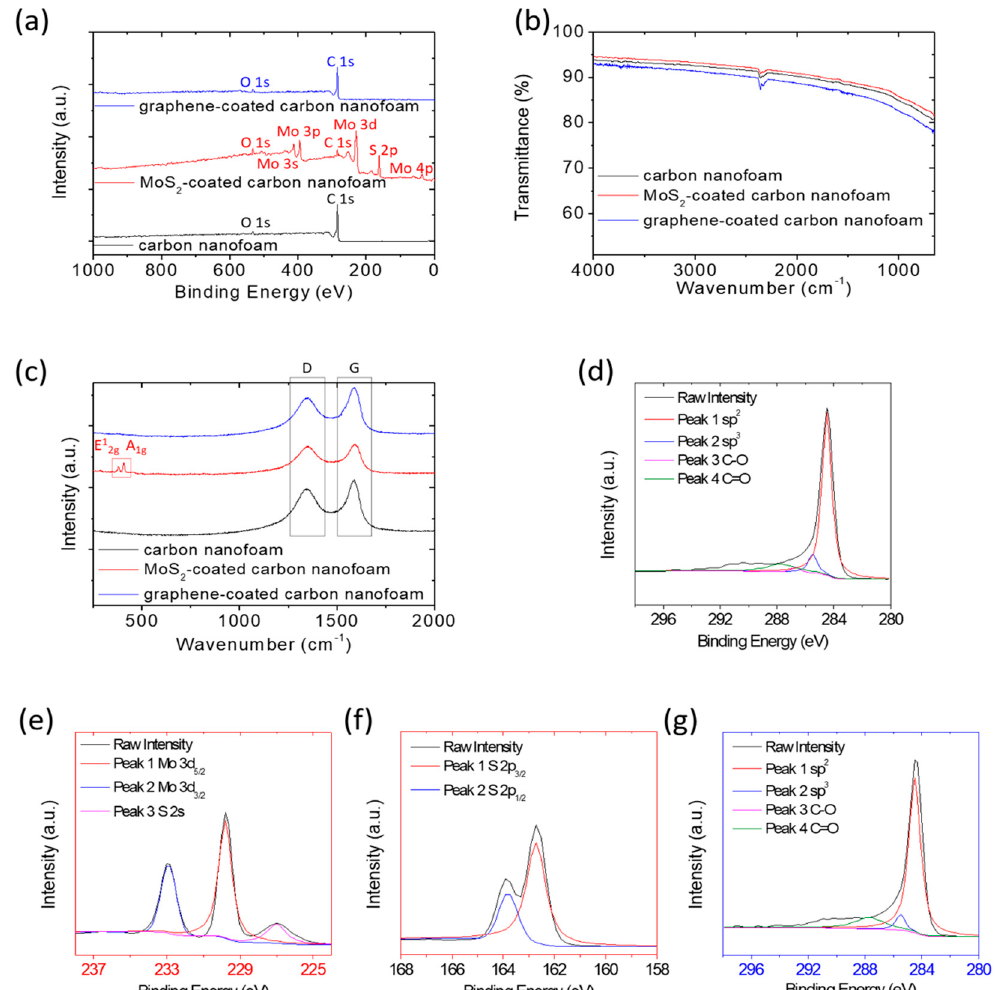
Figure 2. Chemical analysis: ( a ) X-ray photoelectron spectra, ( b ) Fourier-transform infrared spectra, and ( c ) Raman spectra; X-ray photoelectron characteristic-peak analysis of ( d ) carbon nanofoam, ( e , f ) MoS 2 -coated carbon nanofoam, and ( g ) graphene-coated carbon nanofoam.